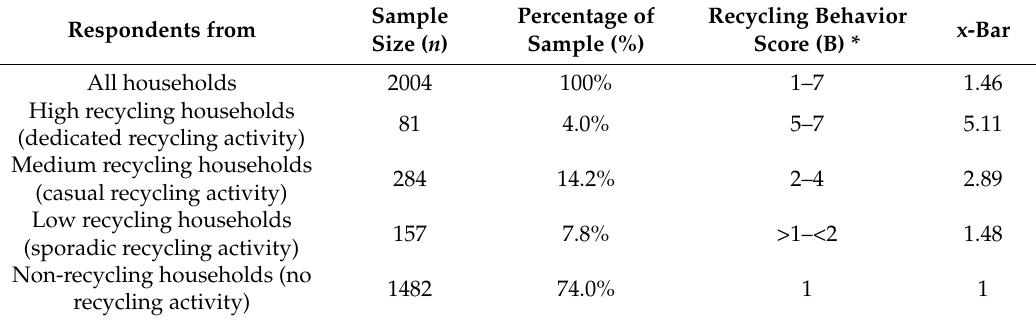
Table 2. Descriptive statistics for the total sample and